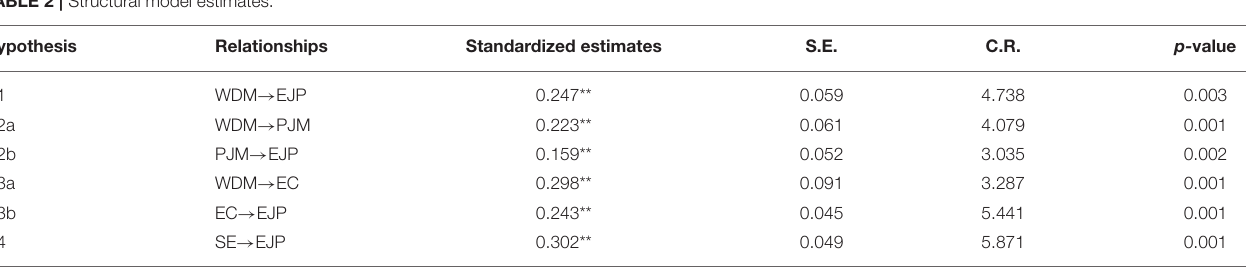
TABLE 2 | Structural model